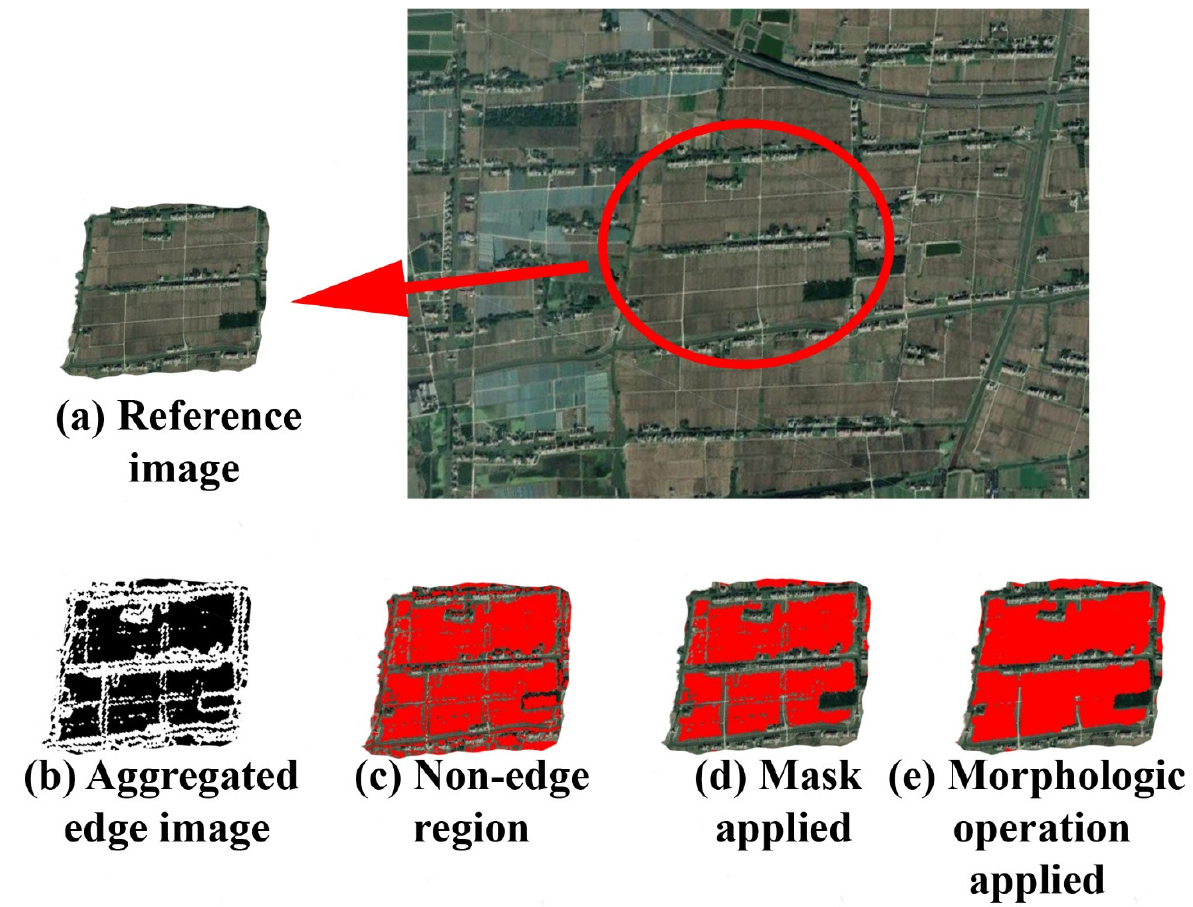
Figure 5. Illustration of the object extraction process.